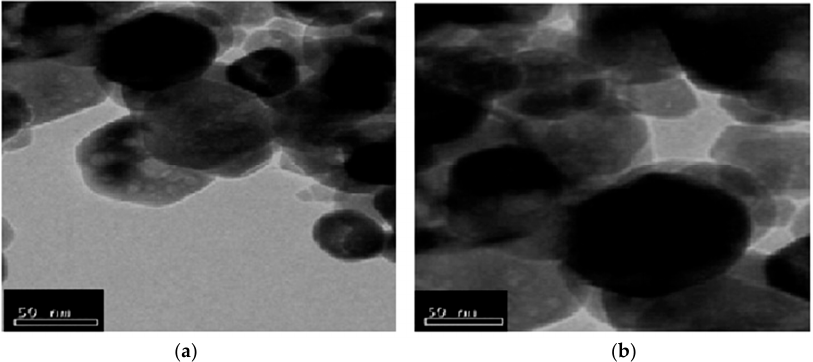
Figure 3. ( a , b ) High Resolution Transmission Electron Microscopy (HR-TEM) images of NiO